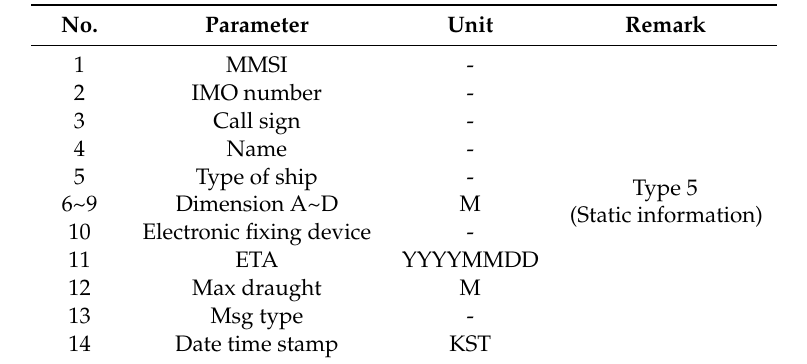
Table 2. Static AIS data